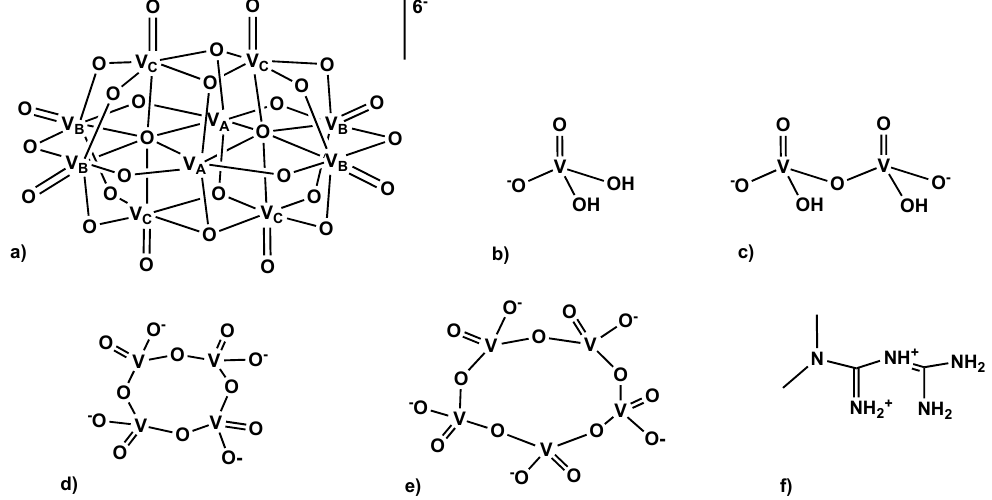
Figure 1. Schematic structure of ( a ) decavanadate anion [V 10 O 28 ] 6− , ( b ) orthovanadate [H 2 VO 4 ] - (V 1 ), metavanadate species like ( c ) [H 2 V 2 O 7 ] 2− (V 2 ), ( d ) [V 4 O 12 ] 4− (V 4 ), ( e ) [V 5 O 15 ] 5− (V 5 ) and ( f ) diprotonated metformin (Metf).